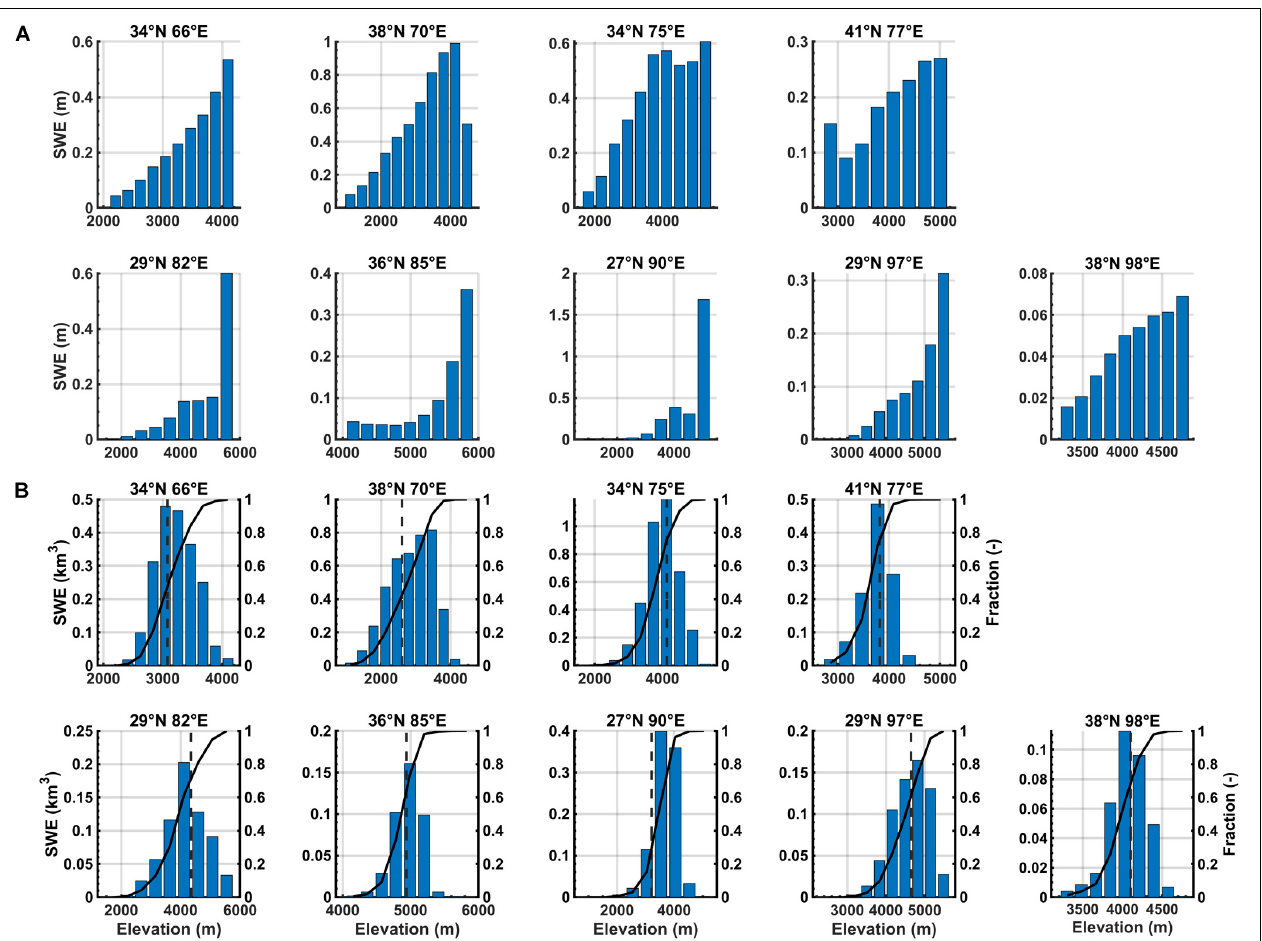
FIGURE 12 | SWE distribution as a function of elevation for HMA test tiles expressed as: (A) bin-averaged SWE depth (in meters) and (B) bin-averaged SWE volume (in km 3 ). For the SWE volume distributions, the cumulative distribution function (solid black line) showing the cumulative fraction of stored volume (right axis) and location of the median elevation (dark gray dashed line) is also